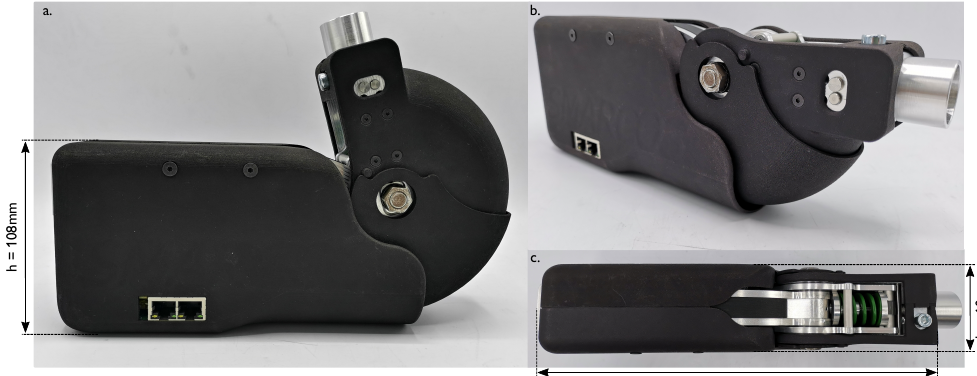
Figure 4. ( a ) Front view of the SMARCOS with cover (at ϕ = 104°). In this position, the hard stop 2 pushes on the input arms to prevent the lever arms from exceeding their operating range of motion. The cover shutter is pulled by the output arm covers to isolate the ball-screw from the external world. The height ( h ) of the actuator is increased by its cover due to the included electronics. Electronics and covers included, the actuator weighs 1.7 kg. ( b ) Isometric view of the SMARCOS with cover (at ϕ = α = 0 ◦ ). The output arm covers push on the cover shutter to retract it in the input arm covers. ( c ) Top view of the SMARCOS with cover (at ϕ = α = 0 ◦ ). With a size of 70 × 55 mm, the electronics can be stored under the actuator without increasing the overall width, which is therefore the same as the one without covers (cf. Figure 2).